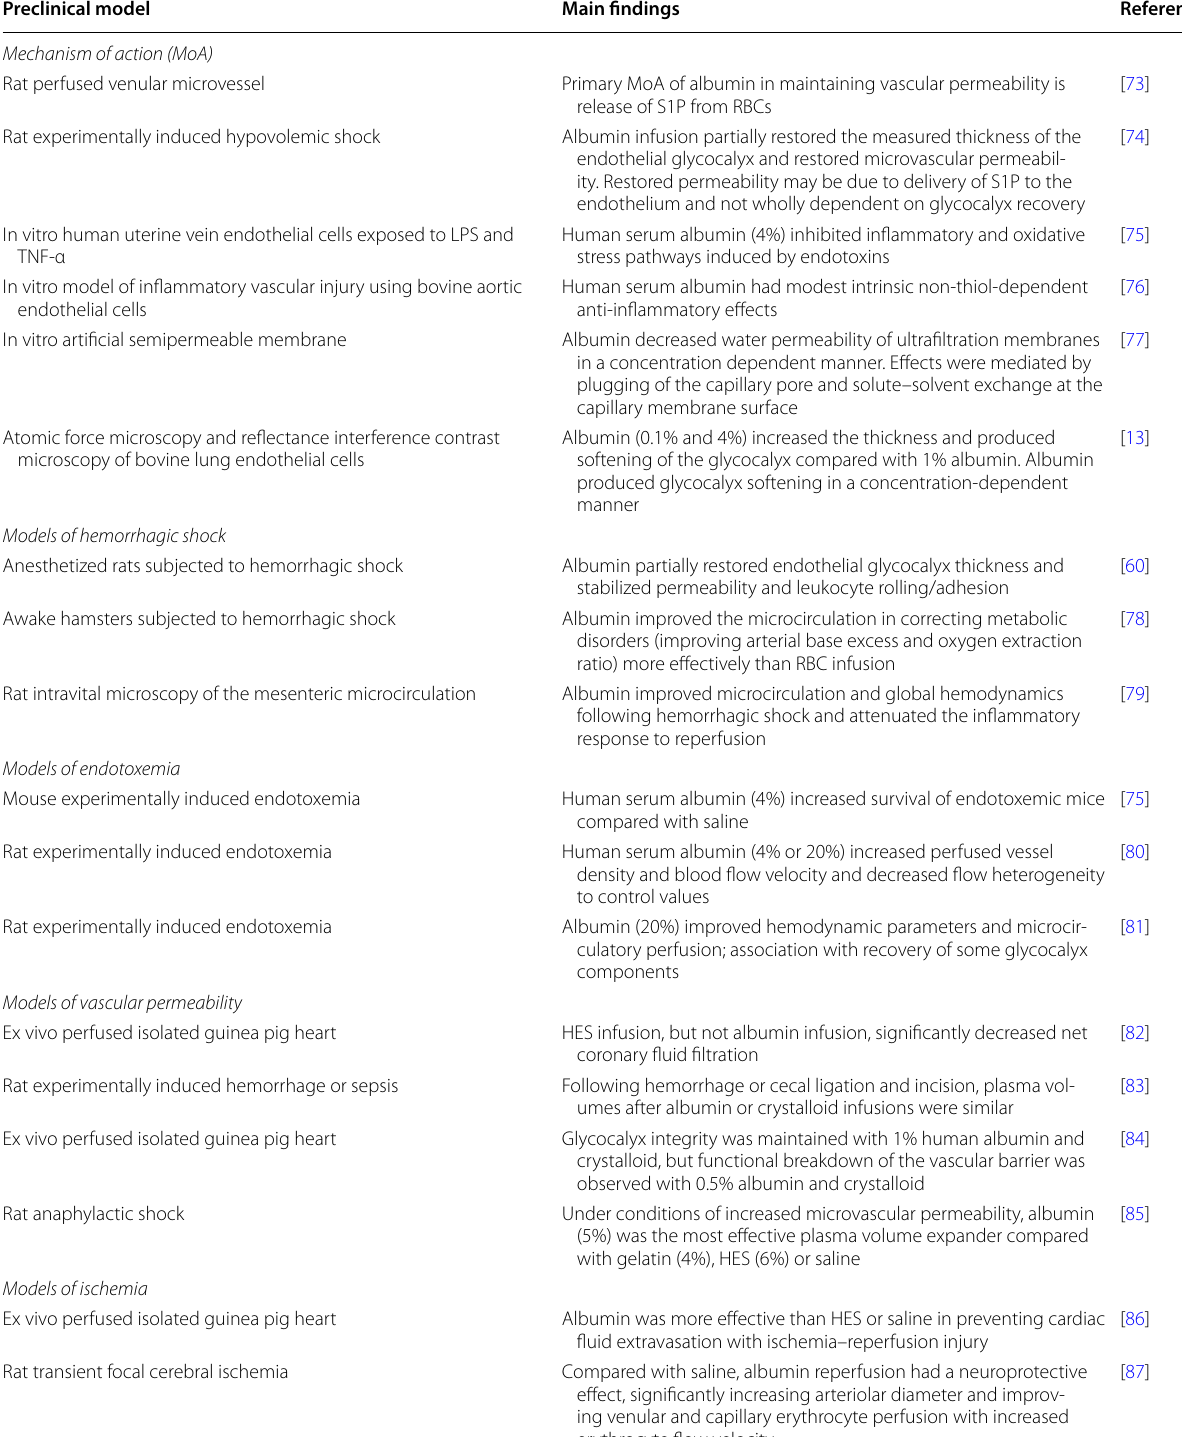
Table 2 Preclinical models of